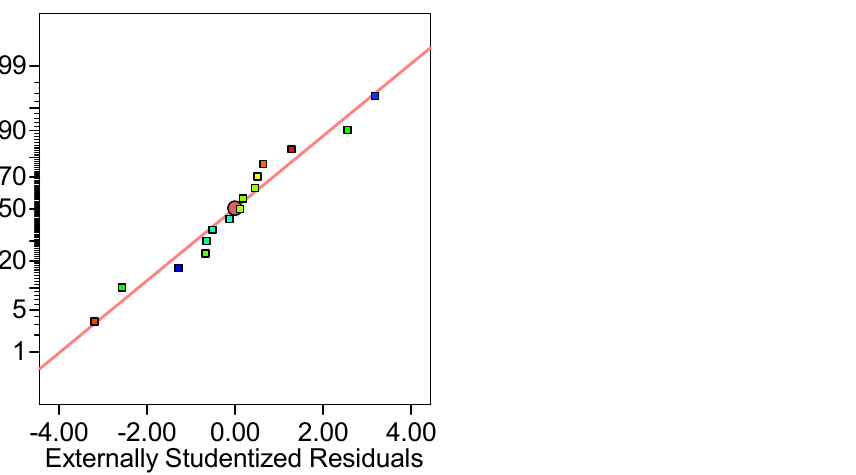
Figure 3. The Normal probability plot of residuals obtained for RB desorption e ffi ciency.